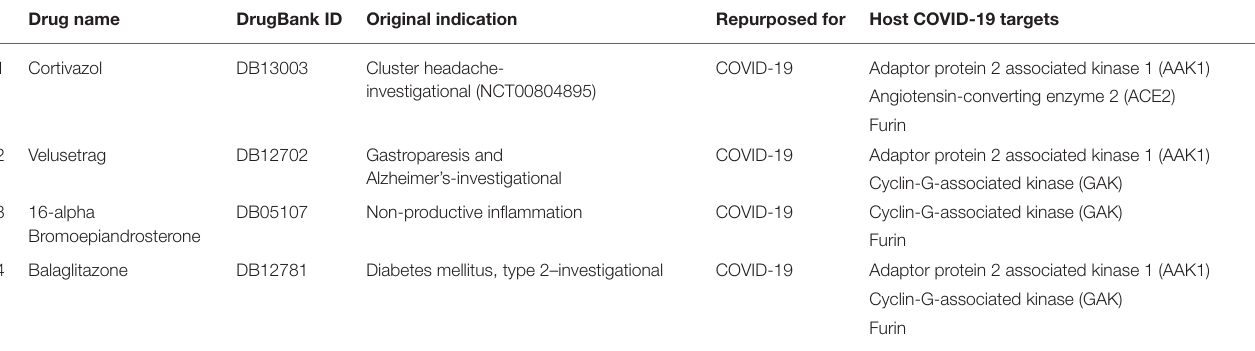
TABLE 6 | Prioritized drugs with their original indication and host COVID-19 targets for which these drugs should be preclinically validated. Drug